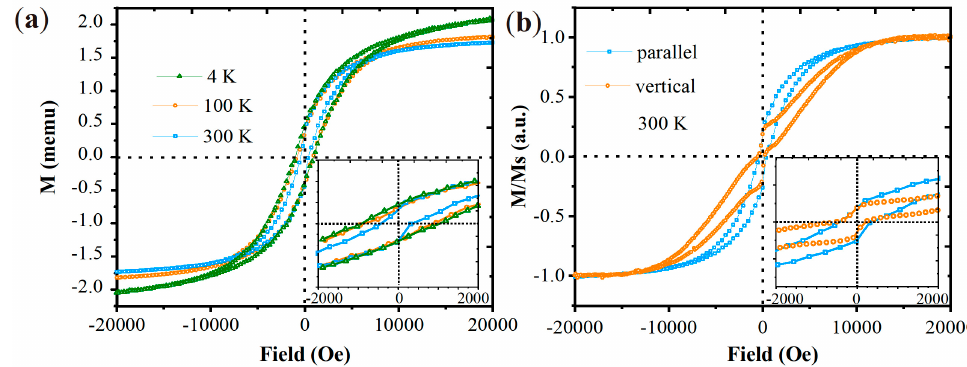
Figure 11. Magnetism of the obtained CFO nanowires, ( a ) hysteresis loops along the parallel direction at 4 K, 100 K, and 300 K and ( b ) hysteresis loops along the parallel and vertical direction at 300 K. The insets show the magnified region.